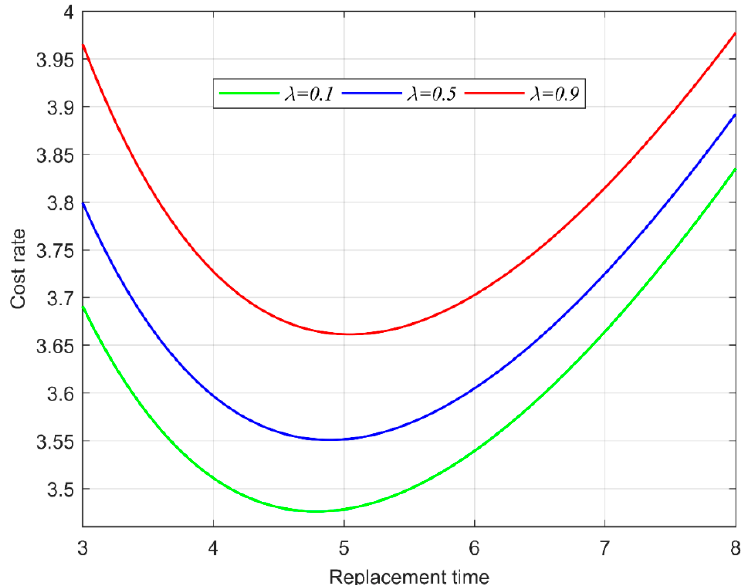
Figure 5. The existence of the optimal post-warranty maintenance policy.